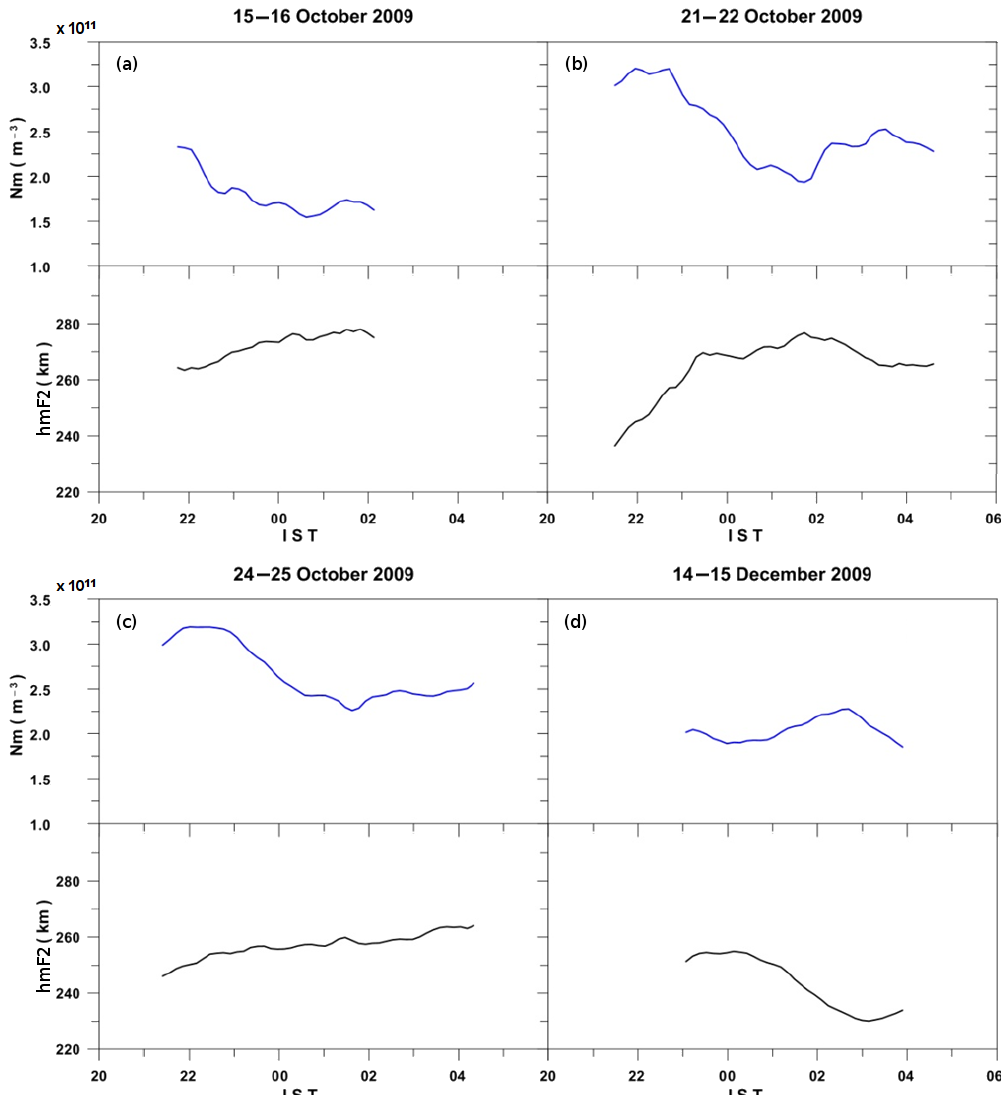
Figure 5. Nocturnal variation of Nm and hmF2 derived using the CP1 calibration term on a few nights in October and December 2009